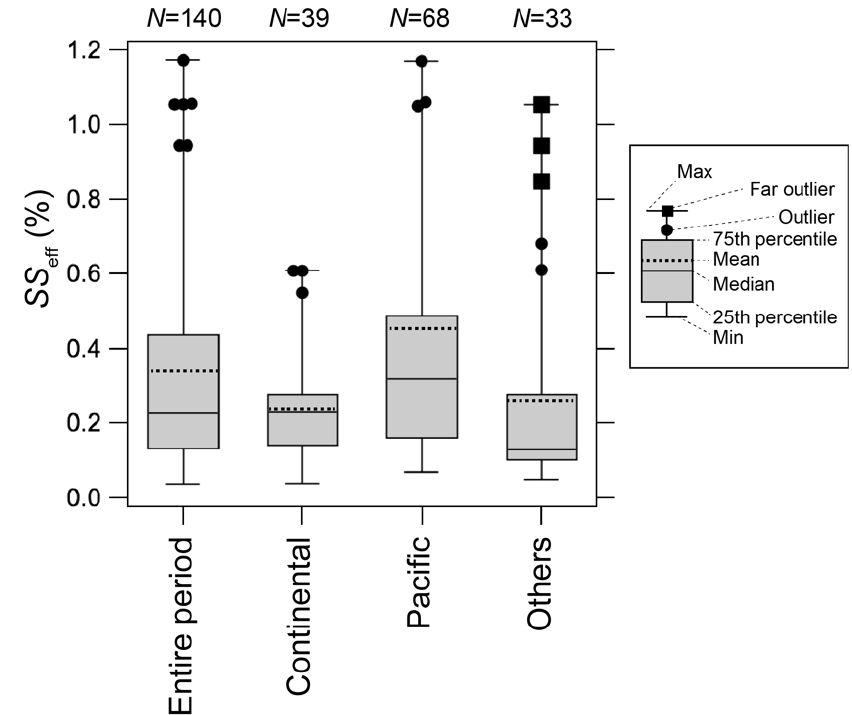
Figure 7. Effective supersaturation ( SS eff ) of clouds at the MFRS classified according to air mass origins. Number of data ( N ) for each group is indicated at the top of the panel.